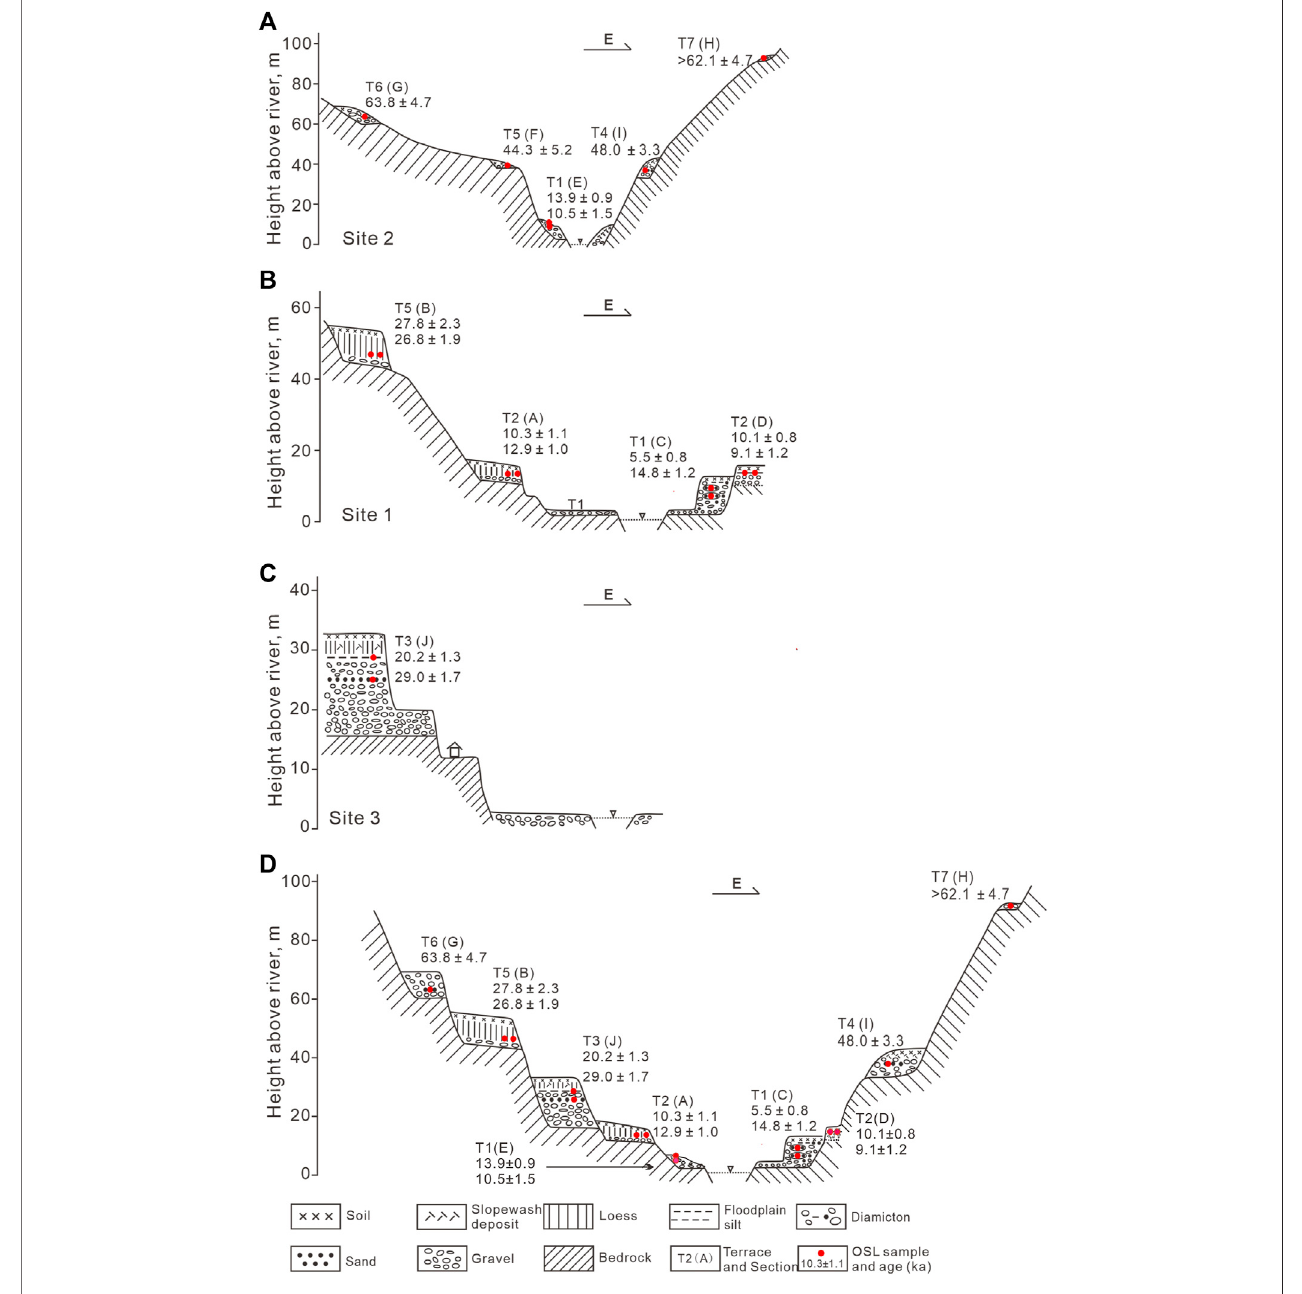
FIGURE 4 | Terrace pro fi les of the Minjiang River in the Songpan area. The localities of sites 2 (A) , 1 (B) and 3 (C) and the sections (letters in brackets) on the terraces are shown in Figure 2 . The CAM ages obtained for the samples are displayed (see text for details). (D) Composite section showing all terraces found in the study